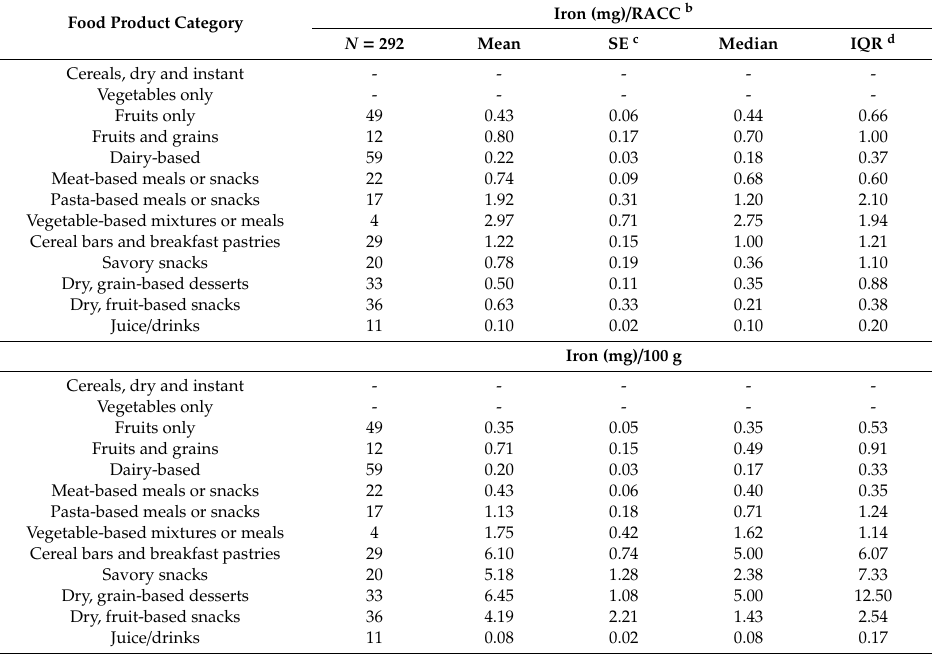
Table 3. Iron content per reference amount customarily consumed (RACC) and per 100 g of toddler a food and drink products by food category,